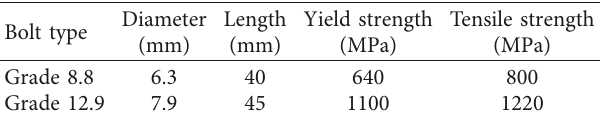
Figure 3: Typical perforated steel plates. Table 5: Properties of bolts.